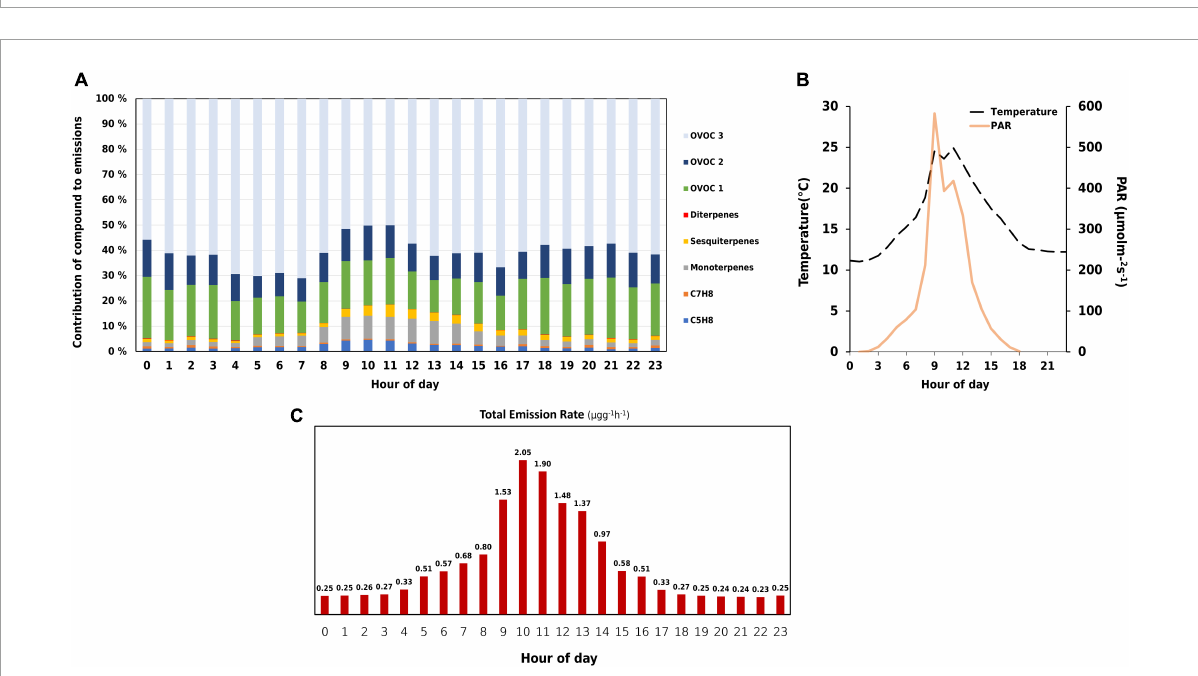
FIGURE3 Plots describing hourly variations of (A) emission contribution of different biogenic volatile organic compounds (BVOCs). Monoterpenes include C 10 H 14 and C 10 H 16 , sesquiterpenes include C 15 H 22 and C 15 H 24 , and diterpenes include C 20 H 32 , C 20 H 36 , and C 20 H 38 . Oxygenated compounds (OVOCs) have been split into three classes based on the oxygen number. OVOC class 1 consists of 1 oxygen, OVOC class 2 consists of compounds with 2, while OVOC class 3 contains compounds with 3 or more. (B) Chamber temperature ( ◦ C) and PAR ( µ mol m - 2 s - 1 ), and (C) total emission rate ( µ gg - 1 h - 1